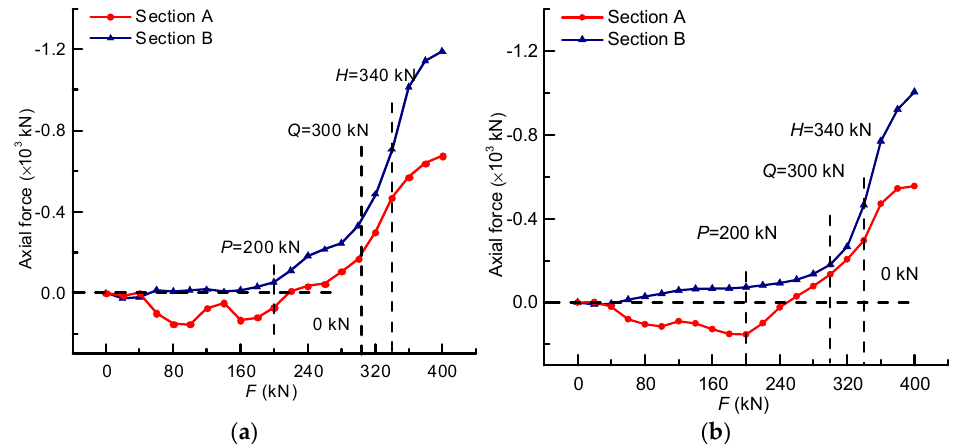
Figure 11. The changing characteristics of the axial force: ( a ) The constructed axial force based on the expanded stress data; ( b ) The axial force of simulated data.